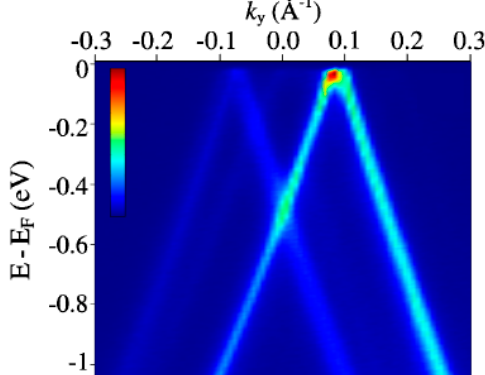
Figure 4. Band structure of EG on (0001) 6H-SiC with 11 epi-layers obtained from ARPES. Two linear Dirac cones are observed. Reprinted with permission from Reference [35]. Copyright (2009) by American Physical Society.